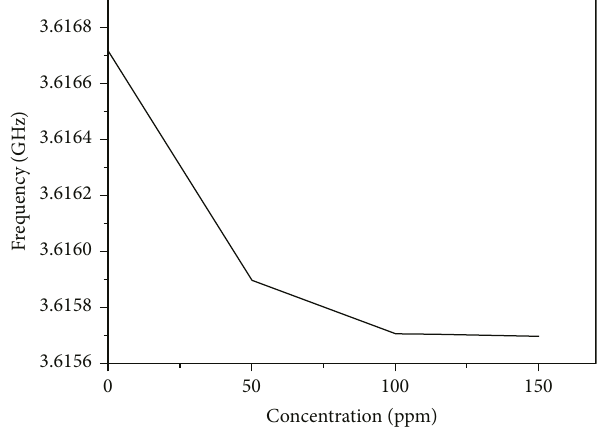
Figure 15: Te concentration measurement results for the ethanol Figure 15. From the concentration curve, we could fnd the sensor has signifcant sensitivity from 0 to 100 ppm. Te real-time frequency shift fgures are shown in Fig- ure 16 below. For acetone and ethanol, the real-time curve was recorded under a 0 V voltage.